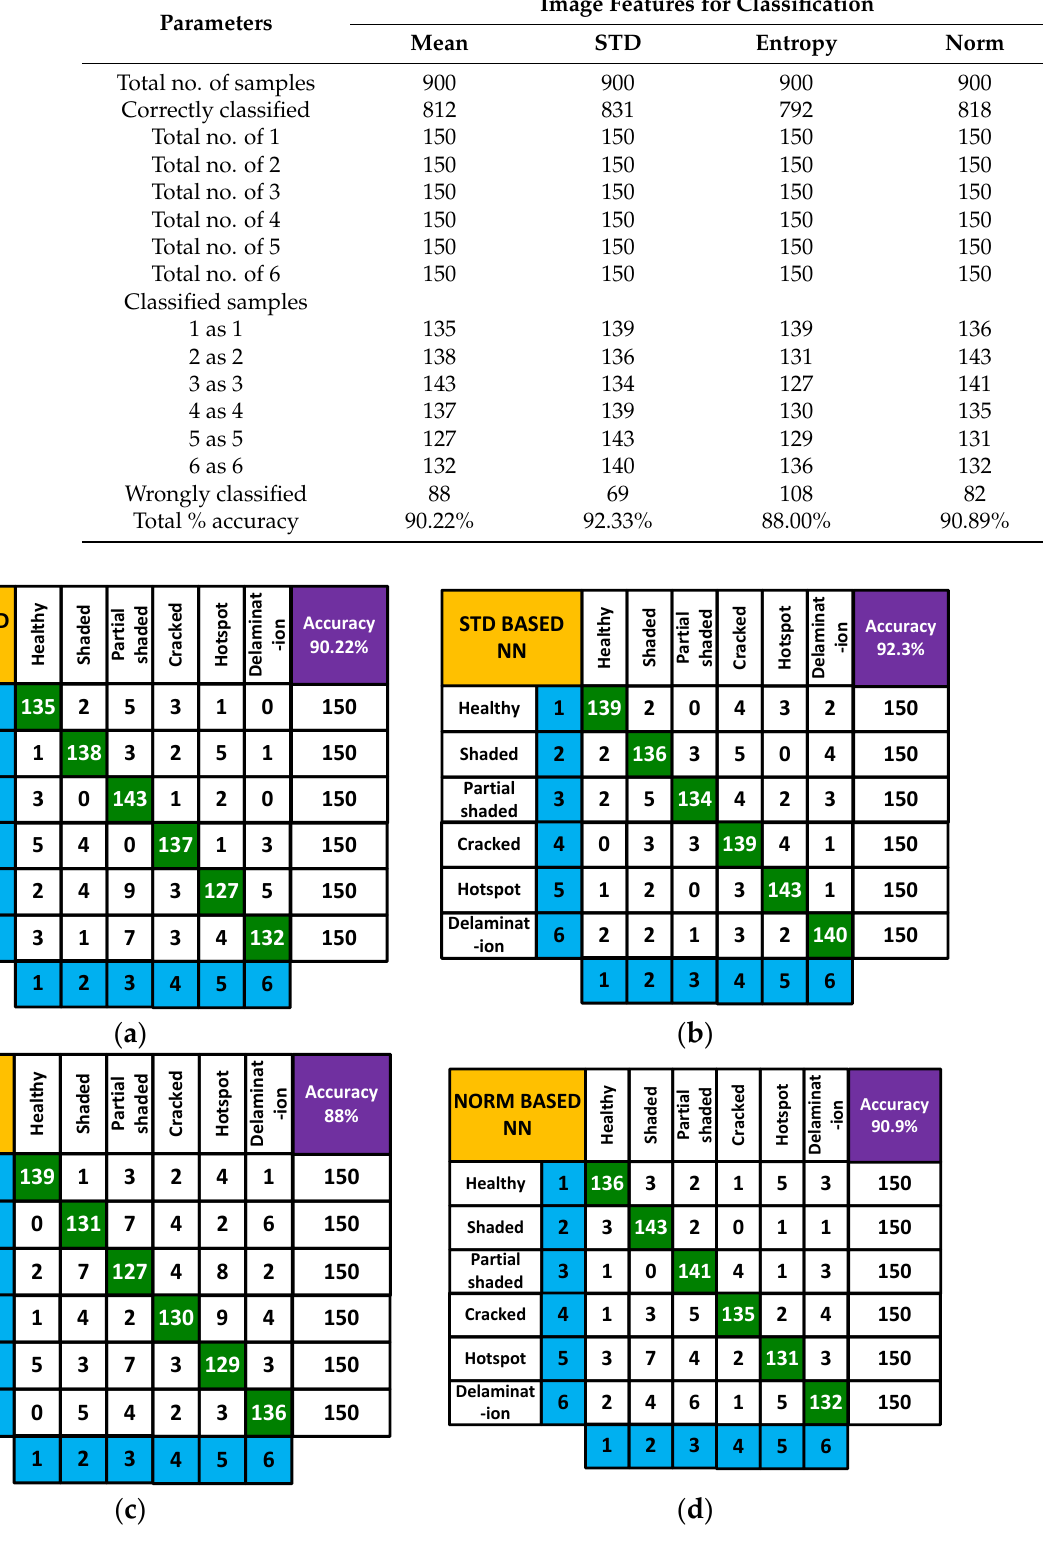
Table 7. Comparison of various classifications during training. Parameters